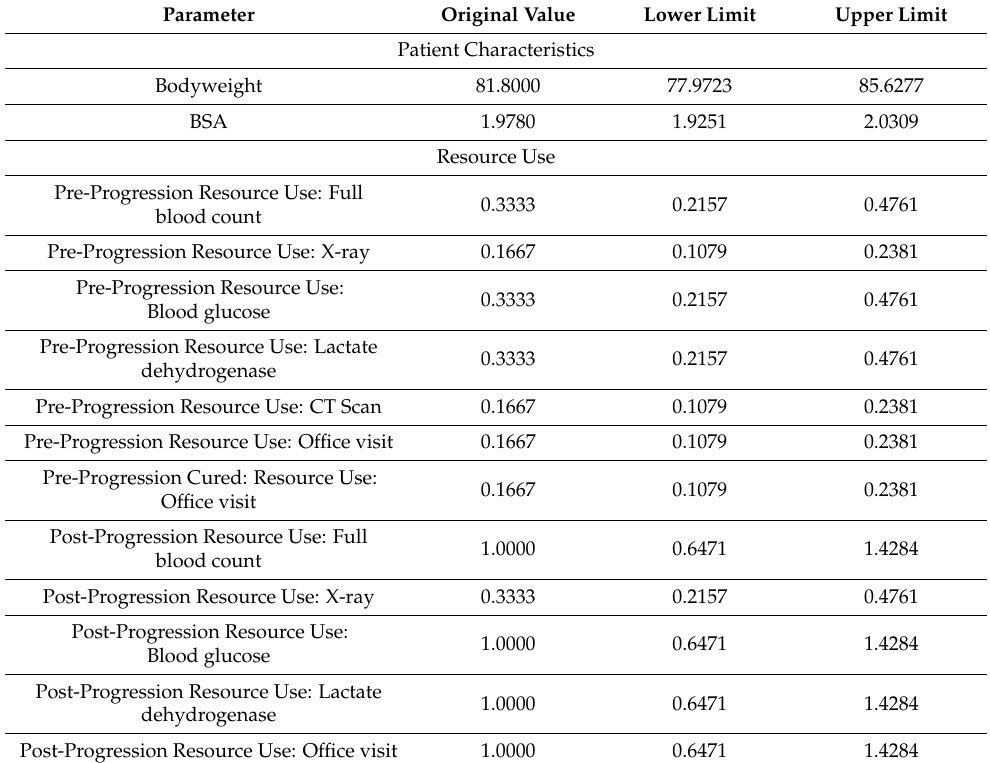
Table A8. Parameter values varied in deterministic sensitivity